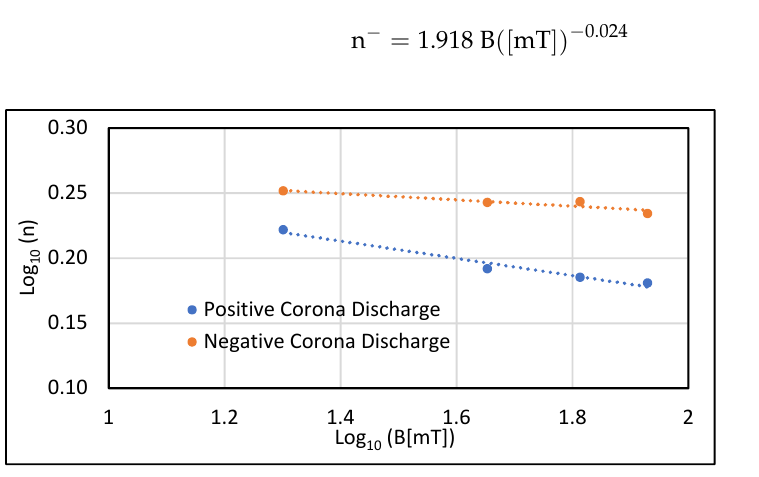
Figure 16. The exponent n versus the crossed magnetic field B on log 10 scale for both discharge po- larities.